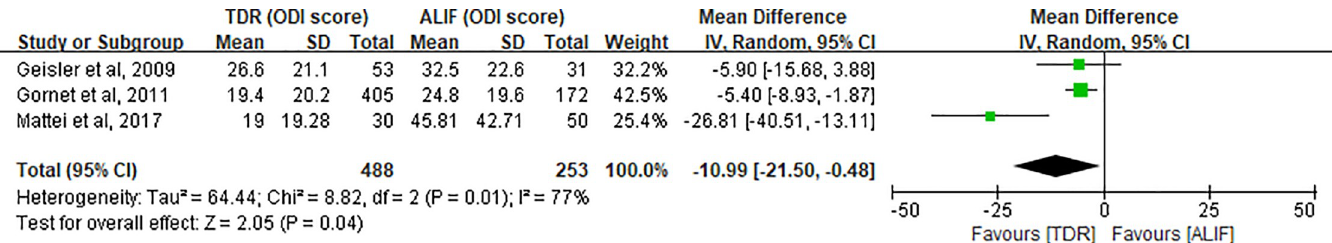
PLOS ONE | https://doi.org/10.1371/journal.pone.0209660 December28,